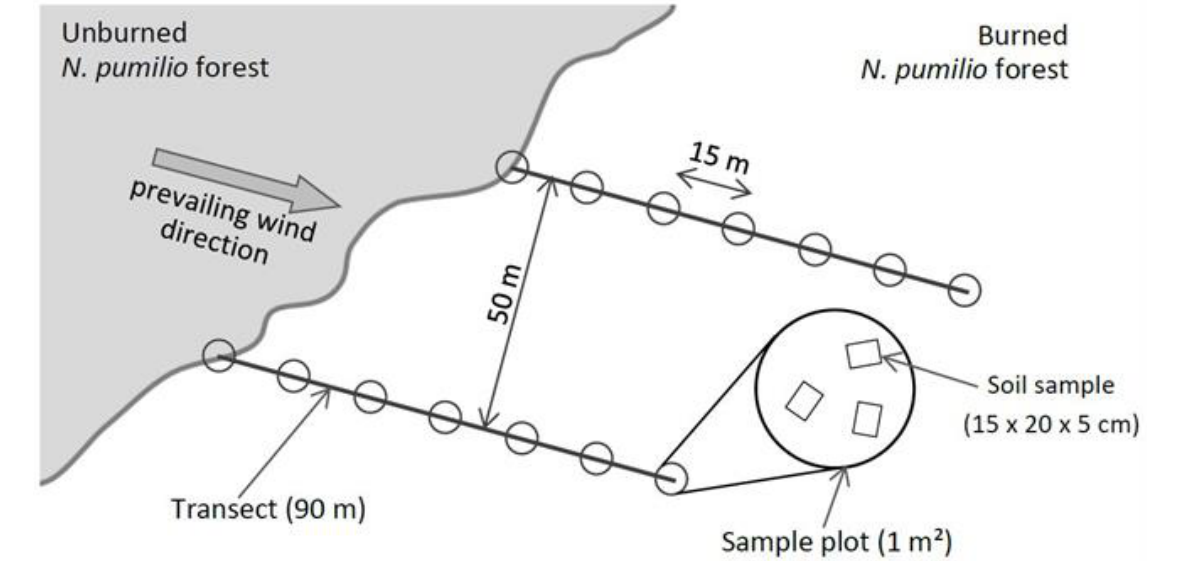
Figure 2. Diagram of sample design: two transects 50 m apart from each other, from the edge of the unburned forest towards the burned area and in the direction of prevailing winds, each with seven plots of 1 m 2 , every 15 m from the edge of the forest up to 90 m.